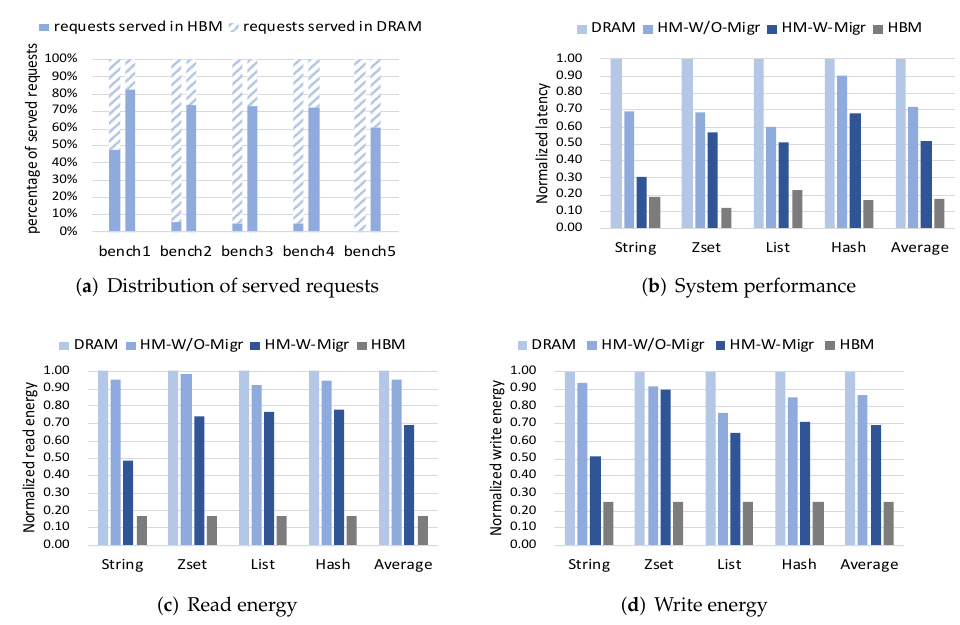
Figure 6. Distribution of served requests on application-level ( a ) and results of four methods on different data structures of Redis ( b – d